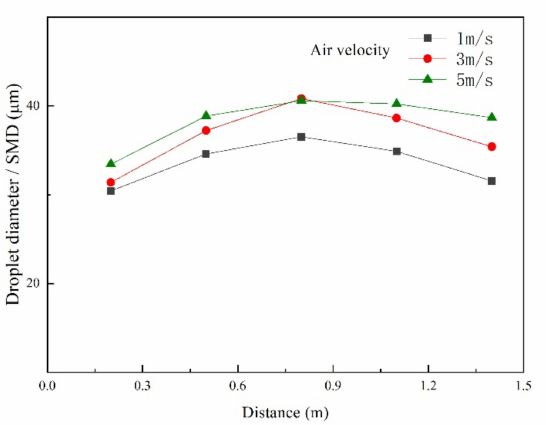
Figure 11. The droplet particle size with different air velocity.